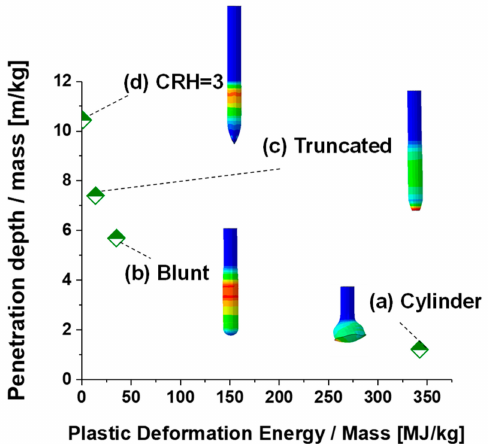
Figure 13. Relationship between penetration depth / mass and plastic deformation energy / mass: ( a ) Cylinder, ( b ) Blunt, ( c ) Truncated, and ( d ) CRH =